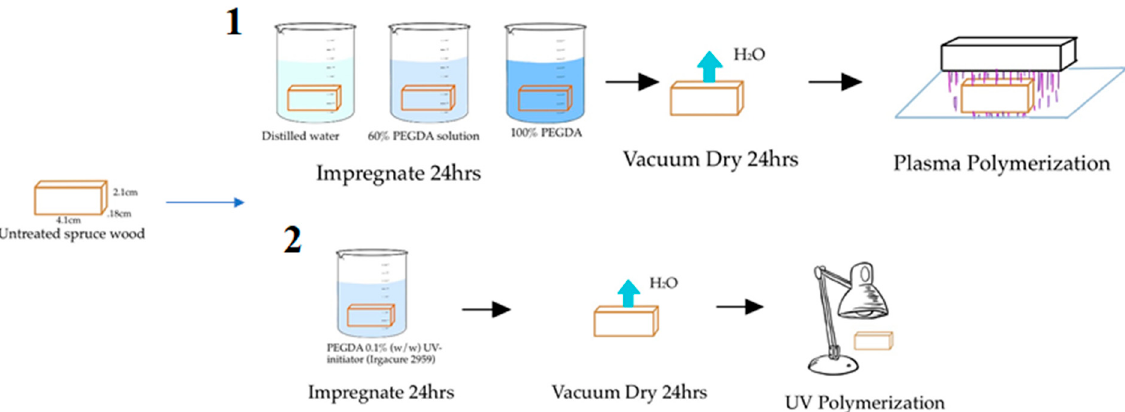
Figure 1. Wood modification process to form the WPCs. Method 1 is for the DBD plasma treatment and method 2 is for the UV treatment.